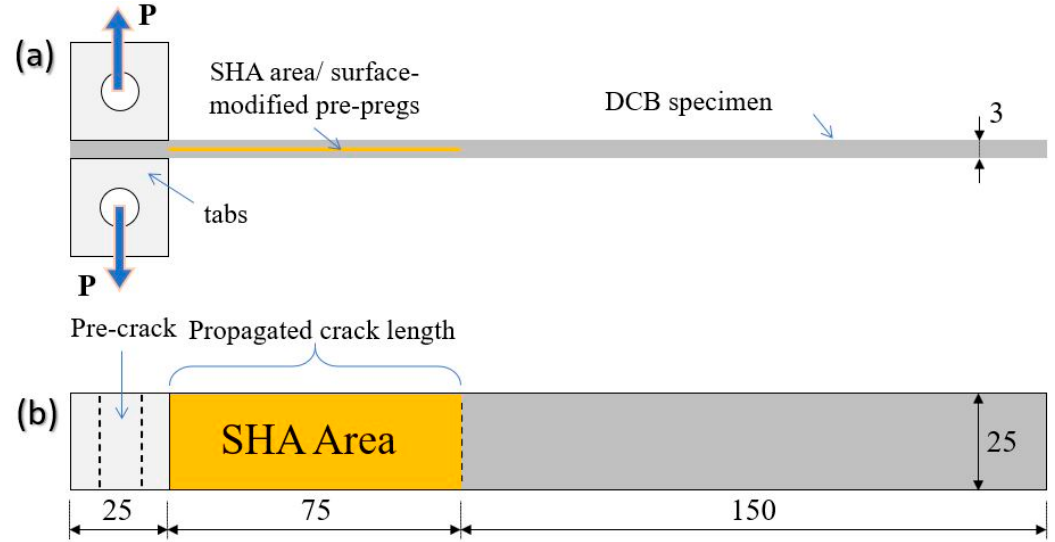
Figure 2. Schematic representation of a modified double cantilever beam (DCB) test configuration: ( a ) side view; ( b ) top view. Dimensions in millimeter (mm).